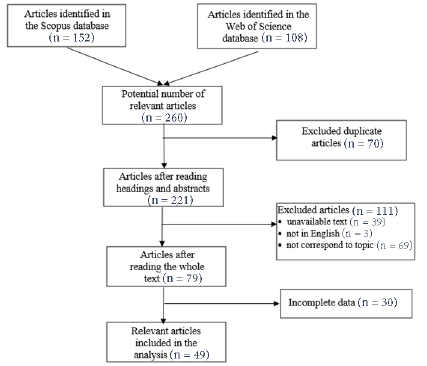
Figure 1. Diagram of relevant article selection